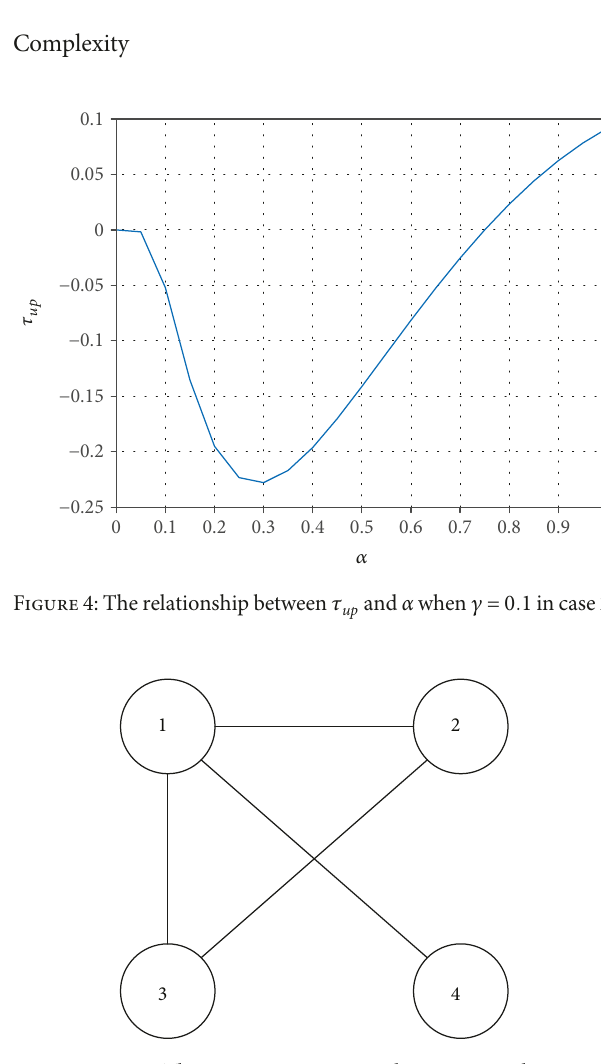
Figure 5: The communication topology in example 1.